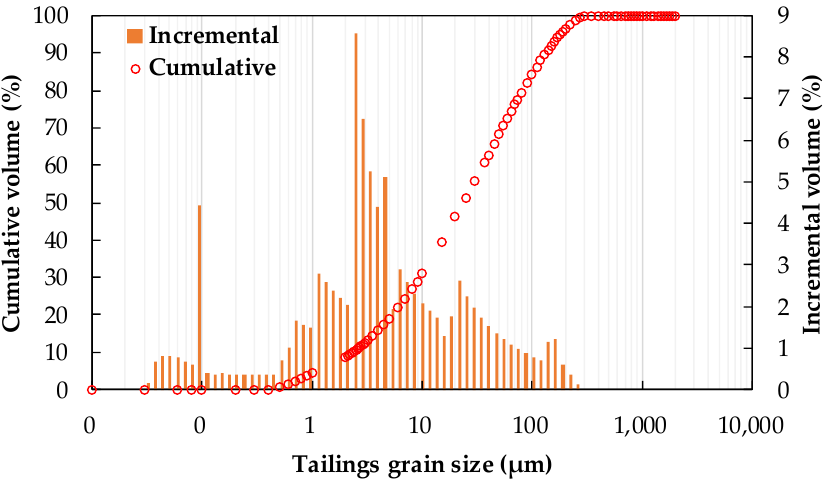
Figure 2. PSD curve of the copper tailings used in the present work. Particles of the size of the tailings below 37 μ m and 75 μ m account for 60.97% and 77.68% respectively.